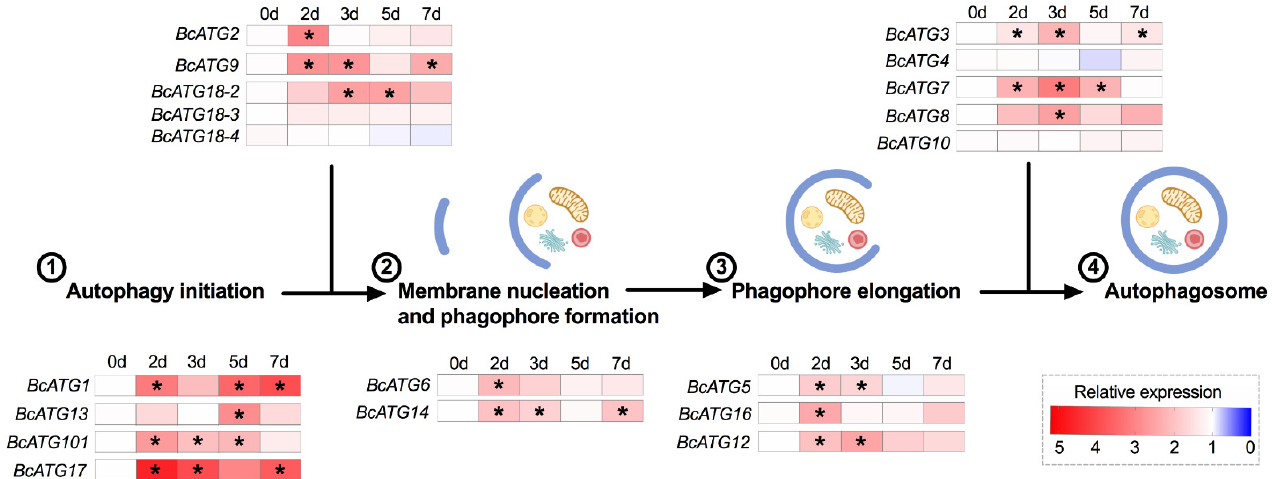
Figure 1. Heat map of gene expression profiles of ATGs upon LsoA infection corresponding to the process of autophagosome formation. 0 d indicates the control, in which psyllids were taken from the Lso-free colony; 2 d, 3 d, 5 d, and 7 d indicate the psyllids were infected by LsoA for 2, 3, 5, and 7 days, respectively (d indicates day). The numbers indicate the steps of autophagosome formation. The asterisks (*) indicate statistical differences compared to control at p < 0.05 using one-way ANOVA with Tukey’s post hoc test.